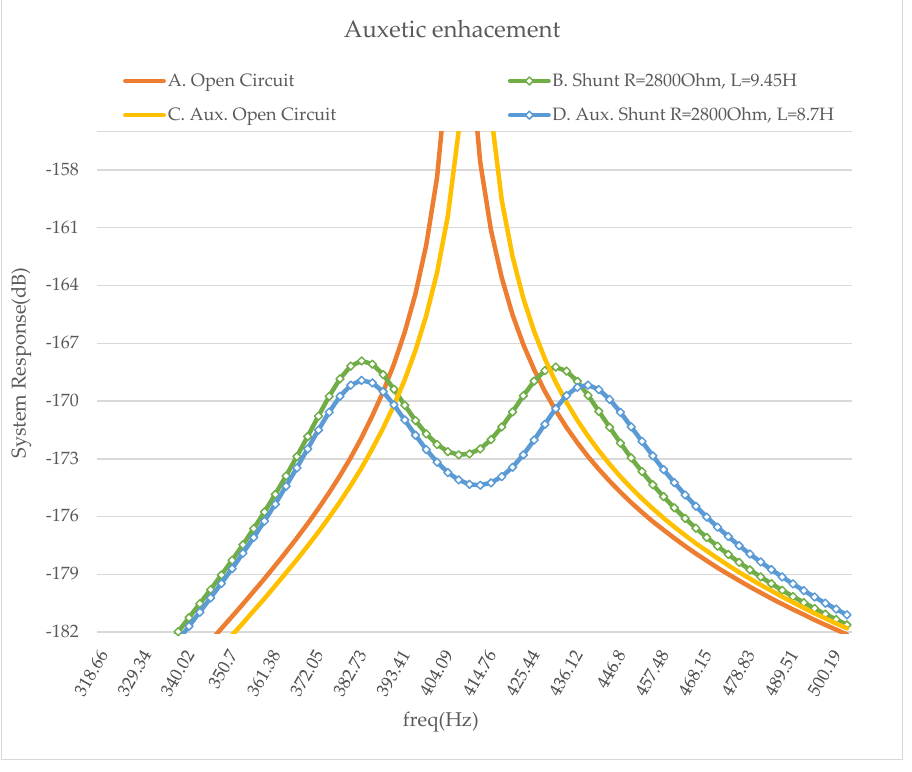
Figure 11. Simulated frequency response of the model. Aluminum beam, Piezo. PIC151, additional layer hA = 0.5 mm and Optimal RL circuit values- A. Open circuit vxy > 0, B. Shunt circuit R = 2800 Ohm L = 9.45 H vxy > 0, C. Open circuit vxy < 0, D. Shunt circuit R = 2800 Ohm L = 8.7 H vxy < 0.